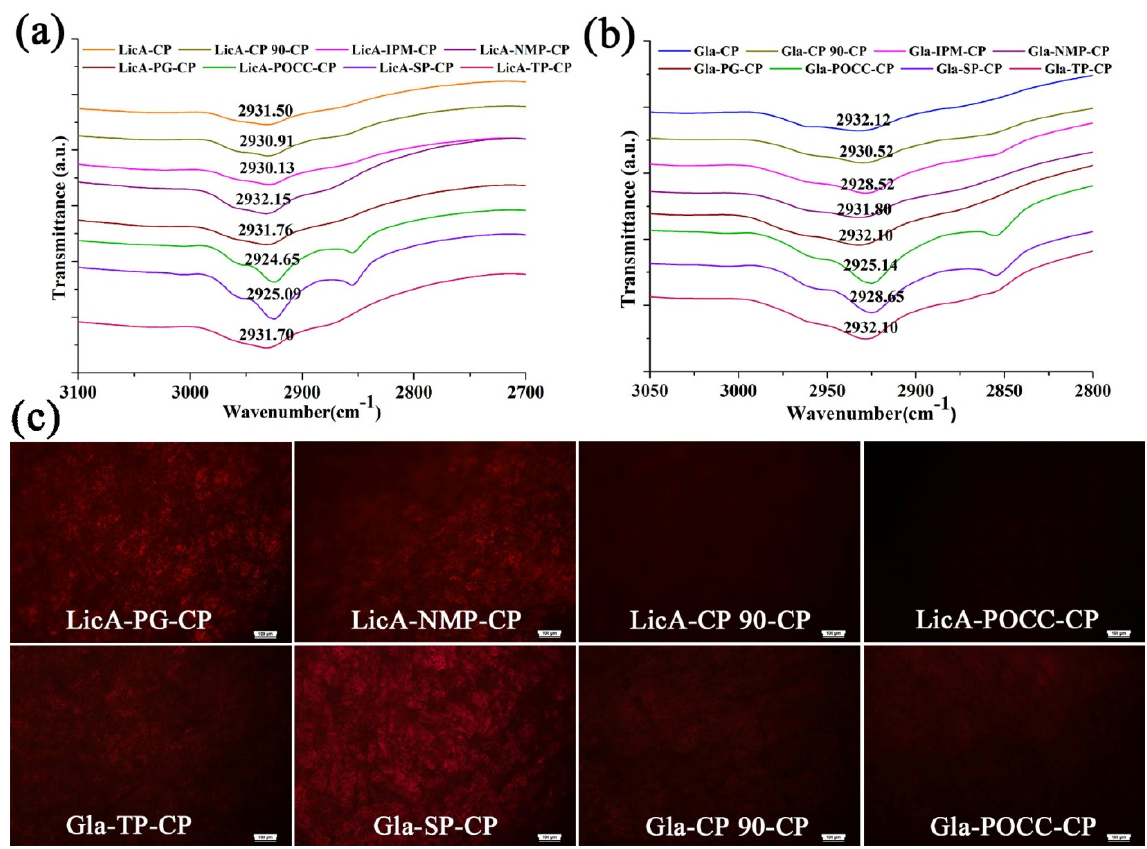
Figure 5. ( a ) FT-IR spectra ( − OH group) of LicA–enhancers–CP systems; ( b ) FT-IR spectra ( − OH group) of Gla–enhancers–CP systems; ( c ) PLM images of drug–CP films after different